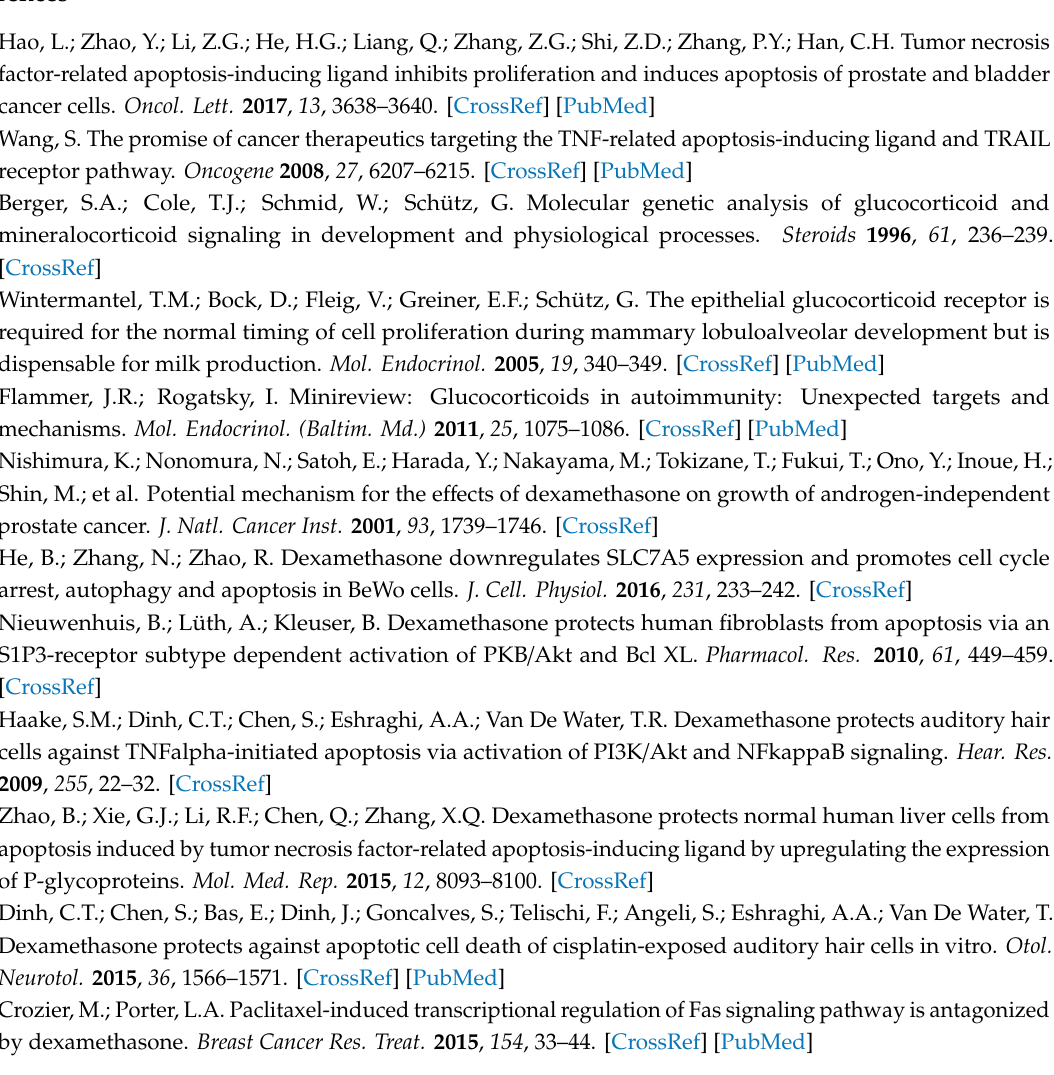
Figure S1: E ff ect of DEX on anti-cancer drugs-induced cell death. Figure S2: E ff ect of various multiple kinases inhibitors on DEX-mediated c-FLIP(L) upregulation. Figure S3: Uncropped image of Western blot for Figure 1. Figure S4: Uncropped image of Western blot for Figure 2. Figure S5: Uncropped image of Western blot for Figure 3. Figure S6: Uncropped image of Western blot for Figure 4. Figure S7: Uncropped image of Western blot for Figure 5. Figure S8: Uncropped image of Western blot for Figure 6. Figure S9: Uncropped image of Western blot for Figure